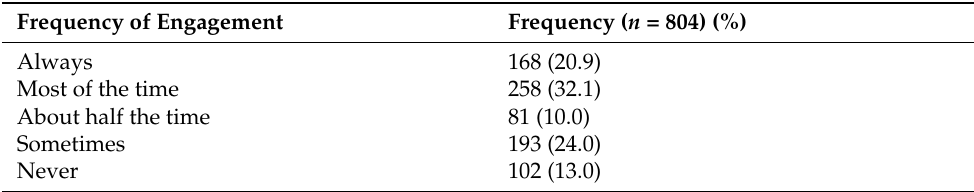
Table 11. Involvement with farmer organization.